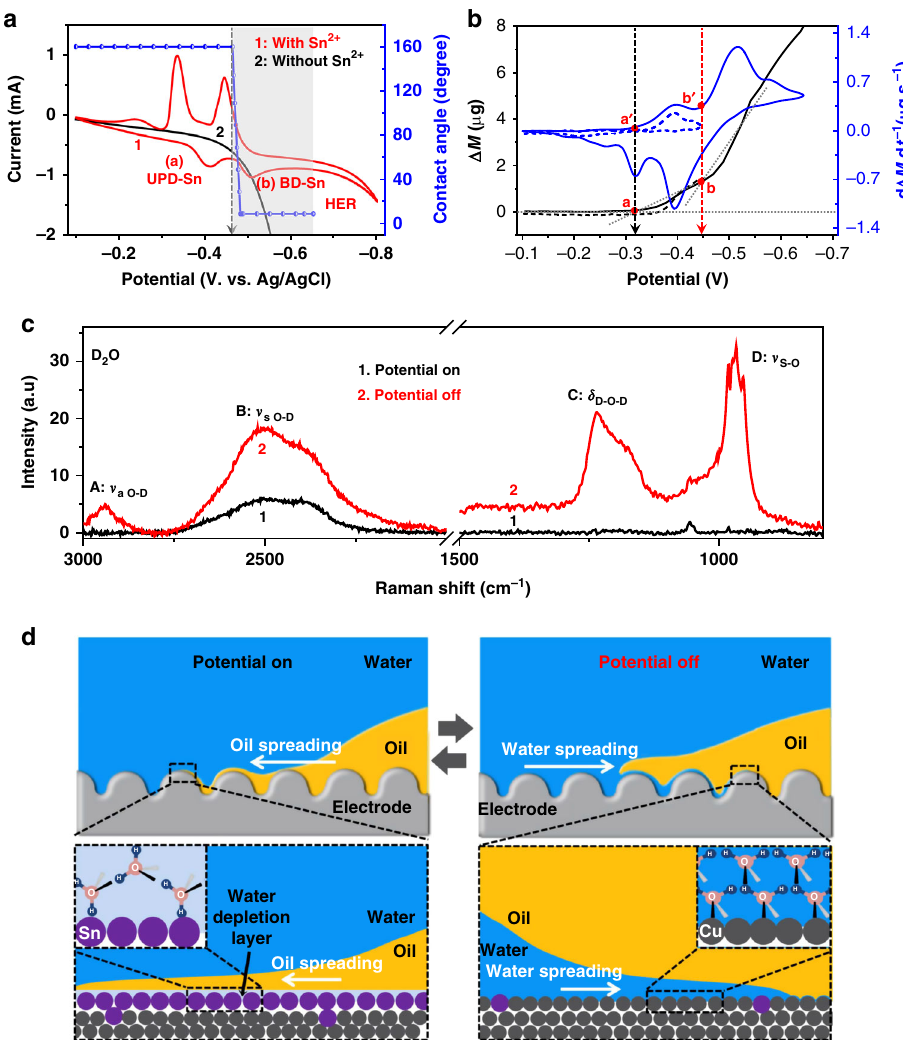
Fig. 2 The binary composite surface governs the in situ reversible superwetting transition. a Cyclic voltammetry of a Cu electrode in H 2 SO 4 /SnSO 4 (red line) and H 2 SO 4 electrolyte (black line). Scan rate: 20 mV s − 1 . b The electrochemical quartz crystal microbalance evaluation of the gravimetric alteration during this in situ reversible superwetting transition. c The in situ Raman spectrum characterization of hydrogen bonding on the electrode surface when the potential was switched on and off. Peaks A and B are assignable to the intermolecular symmetric and antisymmetric stretching vibrations of the hydrogen bond O-D, respectively; peak C is the bending vibration of the D-O-D bond; and peak D is related to the symmetric stretching vibration of the S-O bond. d The schematics show that the Cu/Sn binary composite surface enables drastic altering of the hydrogen-bonding network at the electrolyte/electrode interface, making the oil droplet experience the in situ reversible transition between superphobicity and superphilicity. When the potential is on, the enrichment of Sn atoms inhibits the hydrogen-bonding network on the electrode surface, turning the electrode into the underwater superoleophilic state; when the potential is off, the Cu presents a high af fi nity to the hydroxyl group, leading the surface to return to its intrinsic superphobic